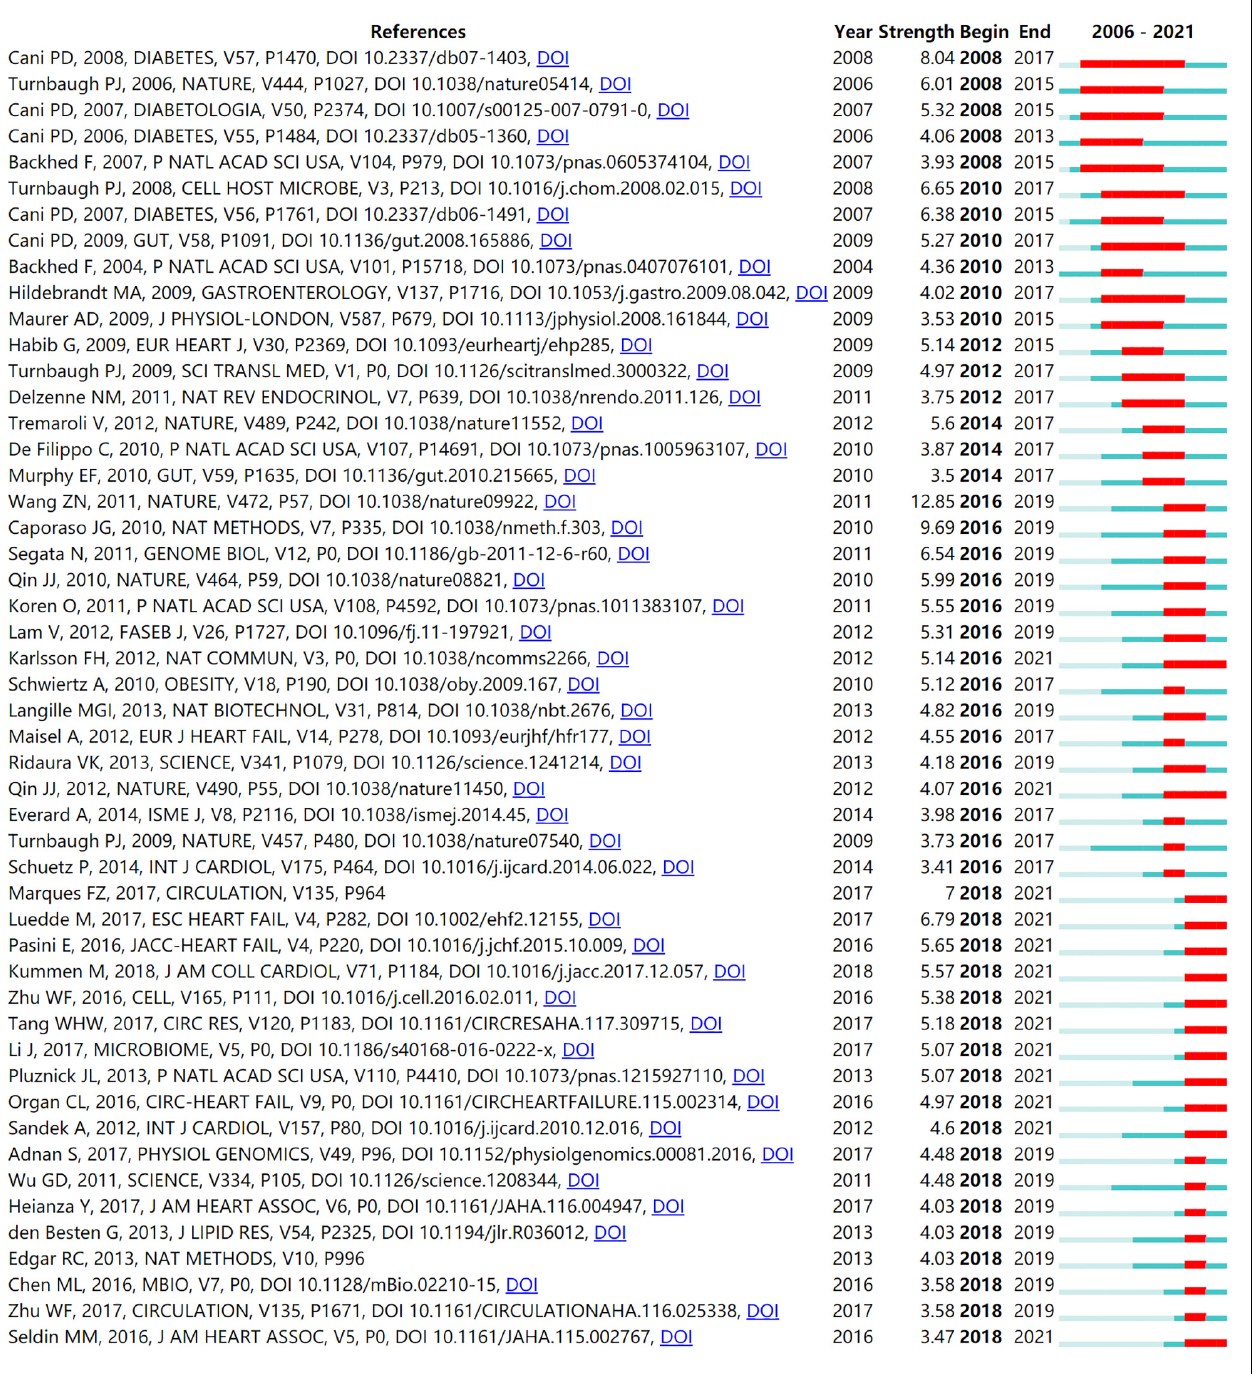
FIGURE 8 | Annual ranking of references with the strongest citation bursts related to gut microbiota research in the heart failure field. The strength values reflect the frequency of citation. Red bars indicate a burst period for the references.